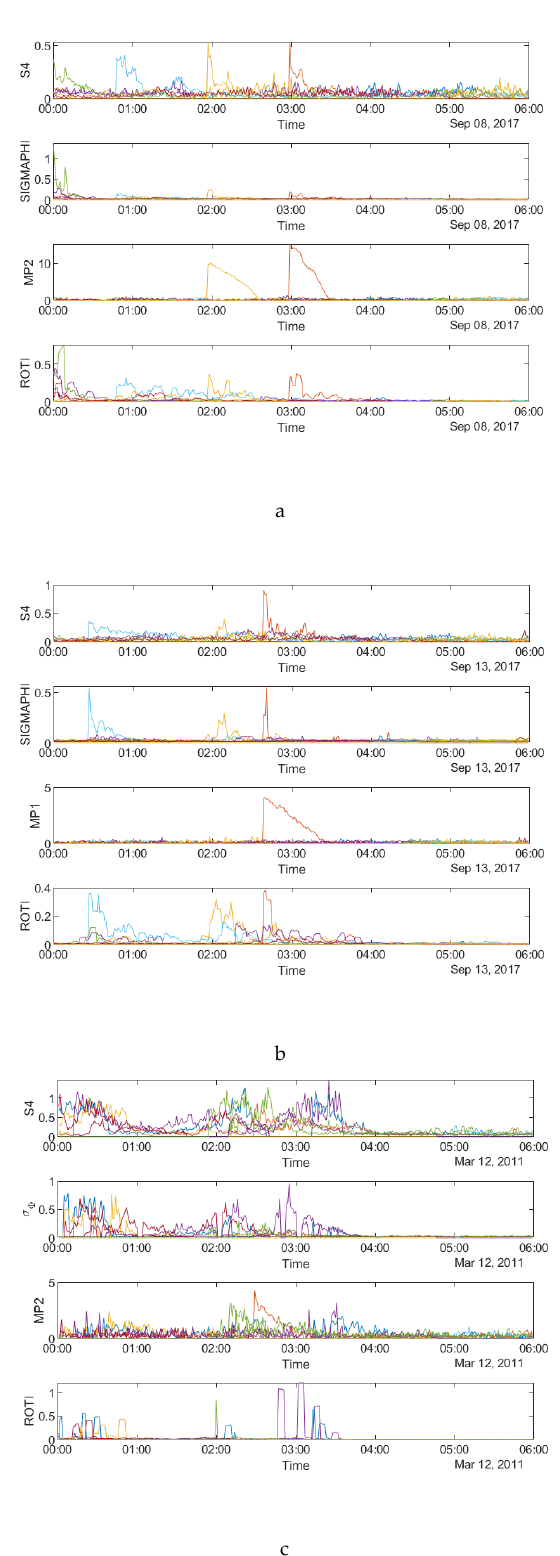
Figure 3. Time series plots of four parameters: ( a ) during 00:00:00–06:00:00 UTC on 8 September, 2017 at SAO0P station; and ( b ) during 00:00:00-06:00:00 UTC on 13 September 2017 at SAO0P station; ( c ) during 00:00:00–06:00:00 UTC on 12 March 2011 at PRU2